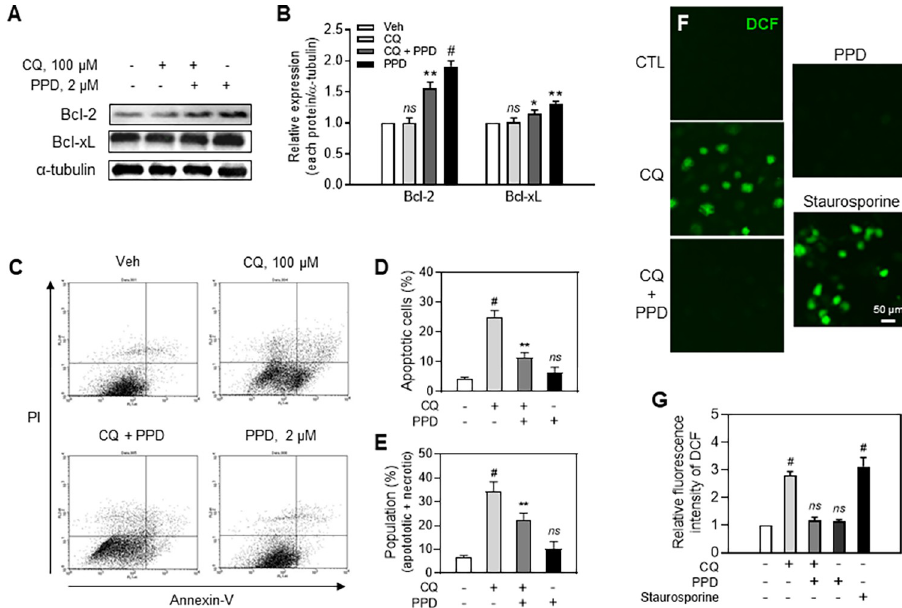
Fig 4. Protopanaxadiol (PPD) protected adult retinal pigment epithelial (APRE)-19 cells from chloroquine- mediated reactive oxygen species (ROS) formation and apoptosis. (A) Western blots and (B) quantitative analysis of Bcl-2 and Bcl-xL in ARPE-19 lysates treated with vehicle, 100 μ M CQ, 2 μ M PPD+100 μ M CQ, and 2 μ M PPD for 6 h. (C) Apoptosis assay using flow cytometry and (D, E) quantitative analysis of apoptosis of ARPE-19 cells treated with different drug combinations for 24 h. Bottom left and right show normal and early apoptotic cells, respectively; top right and left show late apoptotic and necrotic cells, respectively. (F) Fluorescence images and (G) relative intensity of DCF-positive fluorescence in ARPE-19 cells. Cells treated with different drug combinations for 24 h were stained with H 2 DCFDA for 1 h. Staurosporine (0.1 μ M) was positive control for ROS measurement. Means ± standard deviation (SD), ns , � P < 0.05, �� P < 0.01, and # P < 0.001 vs each control.